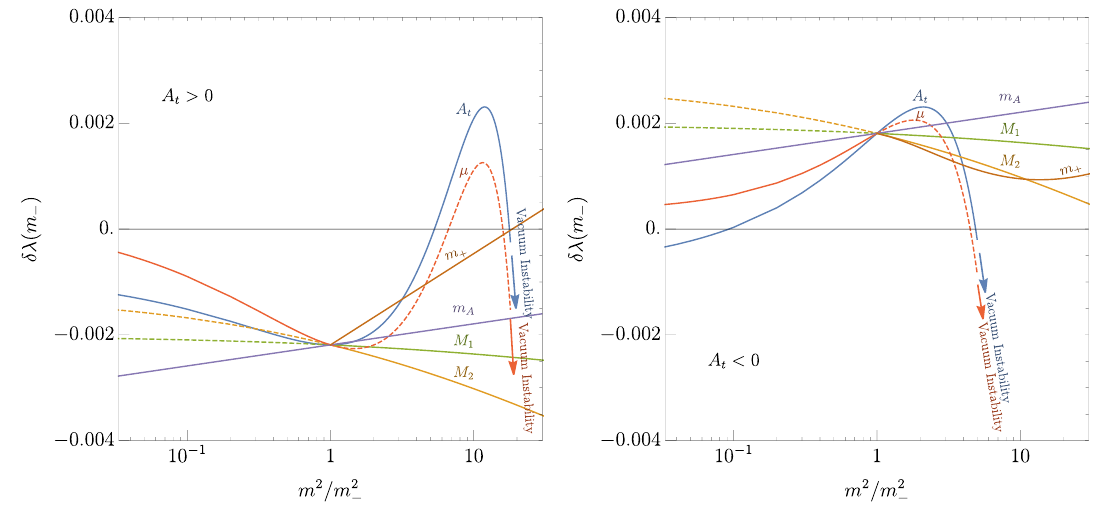
Figure 4 . Threshold corrections to the Higgs quartic coupling as a function of sparticle mass parameters. The six curves correspond to m = ( A t , µ, m + , m A , M 1 , M 2 ) with the remaining five parameters fixed at m − = min( m ˜ q , m ˜¯ ) . The Higgsino can be the LSP on the solid curves, but is u not the LSP on the dashed part of the curves for µ, M 1 and M 2 . Left A t > 0 . Vacuum instability occurs when A t , µ & 4 . 2 m − . Right A t < 0 . Vacuum instability occurs when | A t | , µ & 2 . 2 m −